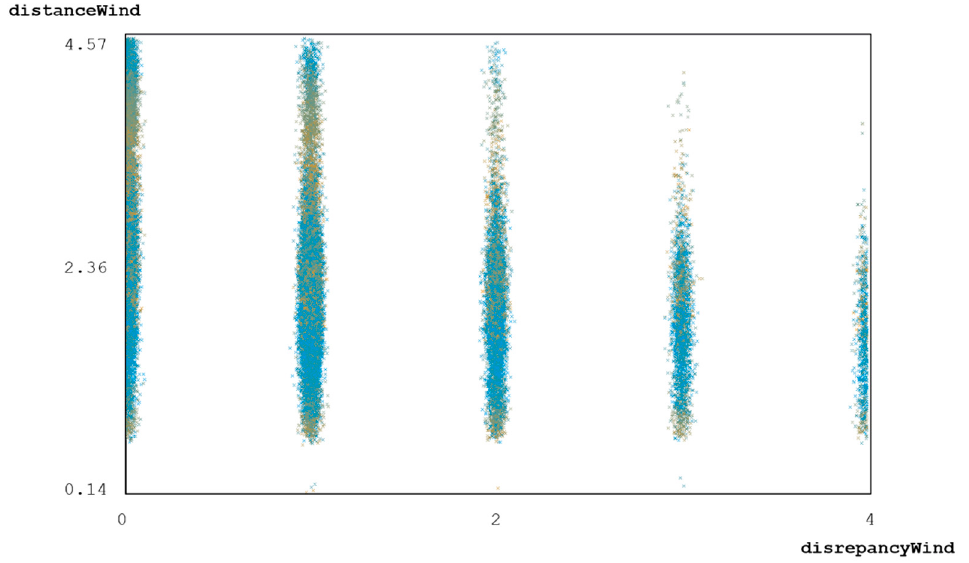
Figure 6. Scatterplot of discrepancies between global and local votes for wind power and potential distances (km) to the nearest wind turbine. The greater the discrepancy, the more the mean distance decreases.